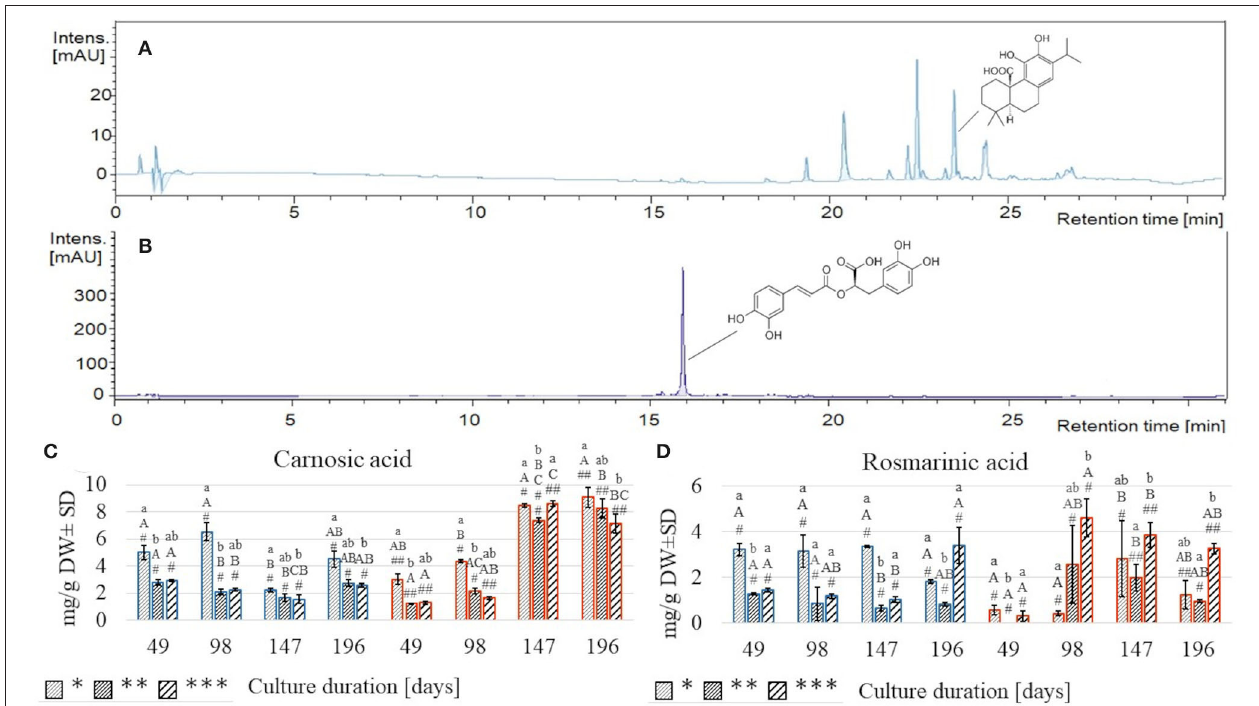
FIGURE 5 | Chromatograms of S. yangii EtOAc extract acquired at 280nm (A) and MeOH extract acquired at 320nm (B) ; the content of carnosic acid (C) and rosmarinic acid (D) in S. yangii shoots cultured under three LI and two temperature regimes. Significant differences were evaluated at p < 0.05 using the Kruskal–Wallis test and are marked with different letters: small letters—differences between samples from three LI; capital letters—differences between samples from four culture durations measured in days; #, ##—differences between samples from two temperature regimes within a single culture duration period; LI: *70 µ mol m −